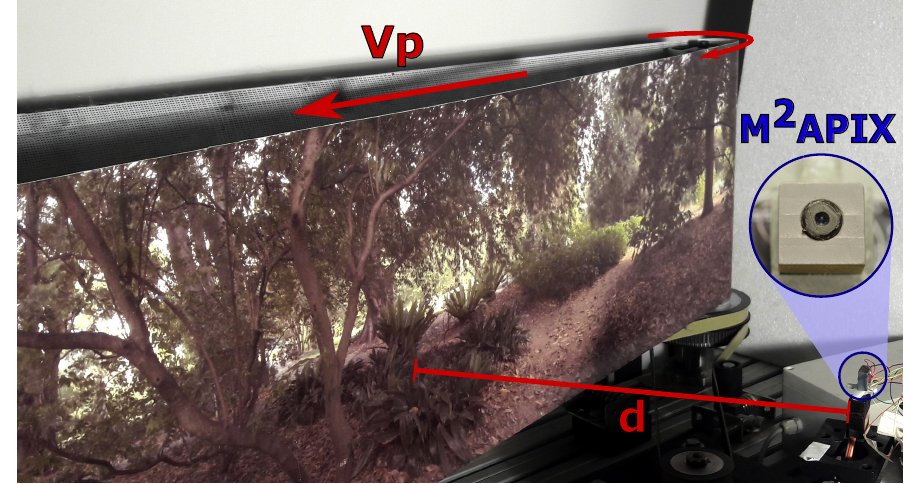
Figure 4. Experimental setup using a moving pattern and varying the artificial lighting to test algorithms with the M 2 APix sensor both in various OF ranges and in various lighting conditions. The pattern speed V p varied from 0 to 1.4 m · s − 1 ; the sensor was placed perpendicularly in front of the moving pattern at a distance d from 8 cm to 40